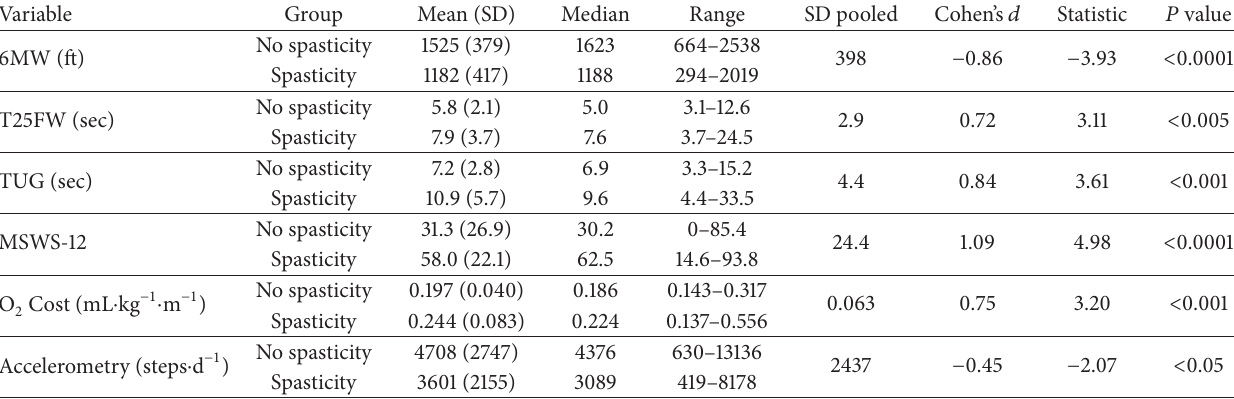
Table 2: Descriptive and effect size data for differences in ambulatory outcomes between the samples of persons who have multiple sclerosis with ( 𝑛 = 44 ) and without ( 𝑛 = 40 ) leg spasticity.